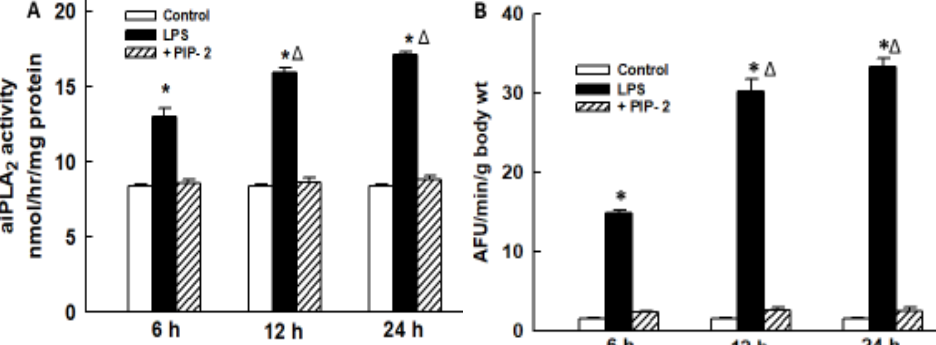
Figure 2. PIP-2 inhibits the increased lung aiPLA2 activity and increased ROS generation after LPS administration. LPS (5 µ g / g body weight) was administered by intratracheal (IT) instillation along with liposomes alone (labeled as LPS) or with PIP-2 in liposomes (labeled as + PIP-2). Control was liposomes alone without LPS (labeled as control). Mice were sacrificed at 6, 12, or 24 h after LPS and lungs were perfused in situ for 15 min with saline solution containing the fluorophore difluorofluoroscein diacetate (DFF-DA). Lungs were then homogenized and assayed for ( A ) aiPLA 2 activity; and ( B ) fluorescence of the lung homogenate as an index of ROS production. Results are mean ± SE for n = 3 for ( A ) and n = 4 for ( B ). * p < 0.05 vs. corresponding control and corresponding + PIP-2 values at the same time point; ∆ p < 0.05 vs. the corresponding value at 6